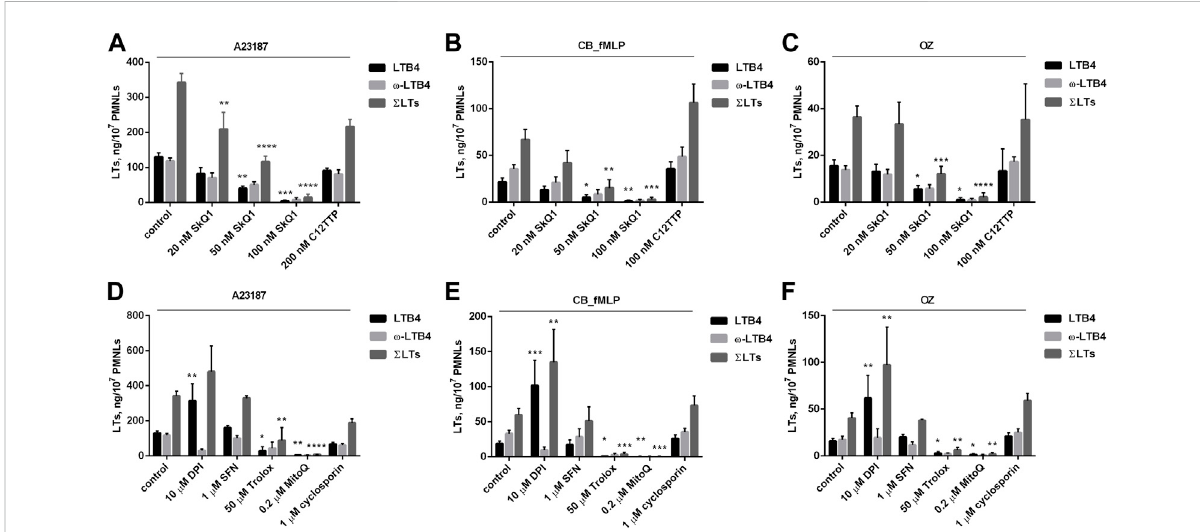
FIGURE 1 Effect of SkQ1 and C12TPP on leukotriene synthesis in human neutrophils (A – C) . Effect of diphenylene iodonium (DPI), sulforaphane (SFN), Trolox, MitoQ and cyclosporin A on leukotriene synthesis in human neutrophils (D – F) . Before treatment, PMNLs (1 – 1.2) × 10 7 /6 ml were pre- incubated for 10 min at 37 ° C at CO 2 incubator. Then cells were treated 30 min with reagents indicated on X -axis. After that, A23187 (1 µM) (A,D) , or cytochalasin B (5 µM) (B,E) or OZ (0.04 mg/ml) (C,F) were added for 10min, then fMLP (0.1 µM) for 10 min (B,E) , as indicated. Values present mean ± SEM of three or more independent experiments performed in duplicate. The 5-LOX products were analyzed using HPLC, and data for LTB4, ω -OH-LTB4 and the sum of leukotrienes ( Σ LTs = LTB4 + trans-LTB4 + ω -OH-LTB4) are presented. * p < 0.05, ** p < 0.01, *** p < 0.001, **** p < 0.0001forpairsofdata(markedcolumncomparedwithcorrespondingcontrolvalue)bytwo-way ANOVAfollowed byTukey ’ smultiplecomparison